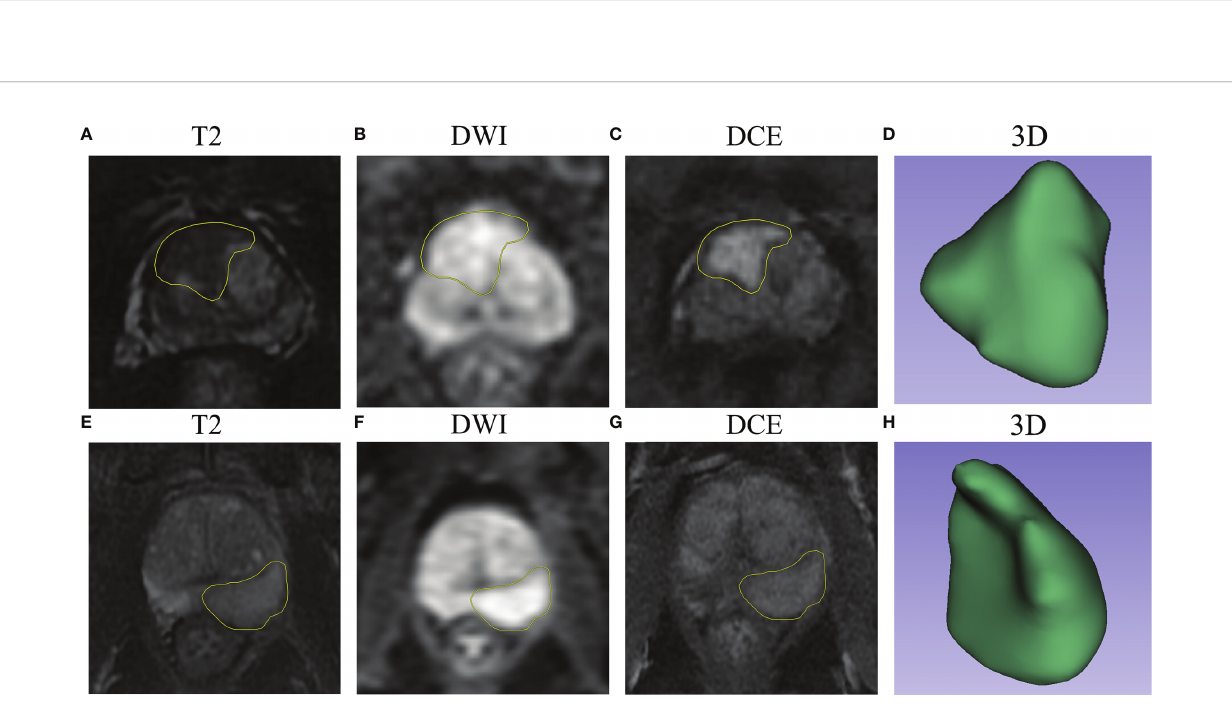
FIGURE 7 | The examples of VOI delineation on MP-MRI. (A – D) A 66-year-old patient was pathologically diagnosed as PNI positive with a typical abnormal signal lesion in the right front of the prostate. (E – H) A 70-year-old patient was diagnosed as PNI negative with a lesion located in the left peripheral zone, and the DCE sequence showed moderate enhancement. (D, H) represent the 3-dimensional reconstruction of the